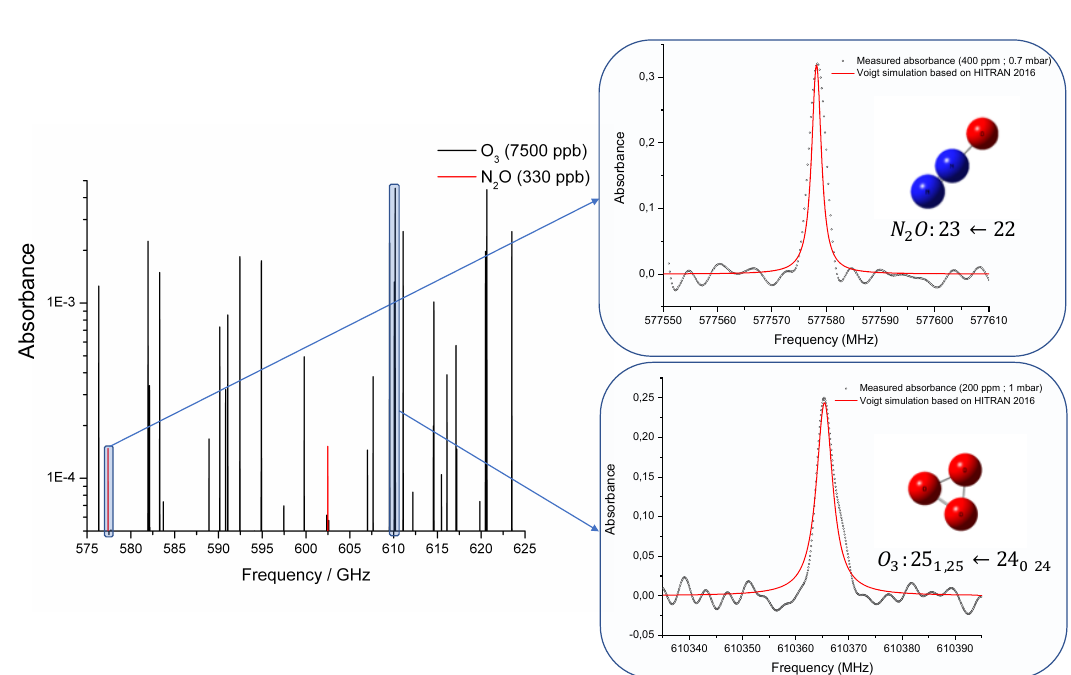
Figure 4. Left: Simulation of the rotational absorption in the 575–625 frequency region of N 2 O and O 3 at tropospheric (330 ppb) and stratospheric (7.5 ppm) concentrations, respectively, for a THz pathlength of 200 m. Right: 400 ppm of N 2 O at P = 0.7 mbar and 200 ppm of O 3 at P = 1.0 mbar measured in CHARME with the MultiCHARME setup in a 4 × 5 Chernin configuration providing a THz pathlength of 200 m (black open circles). Both lines have been measured with an amplitude modulated at 4.5 kHz. An additional frequency modulation at 50 kHz with a 1.1 MHz depth was added to limit the baseline oscillations. The red solid lines correspond to Voigt profiles simulated with HITRAN2016 tabulated frequencies, linewidths and